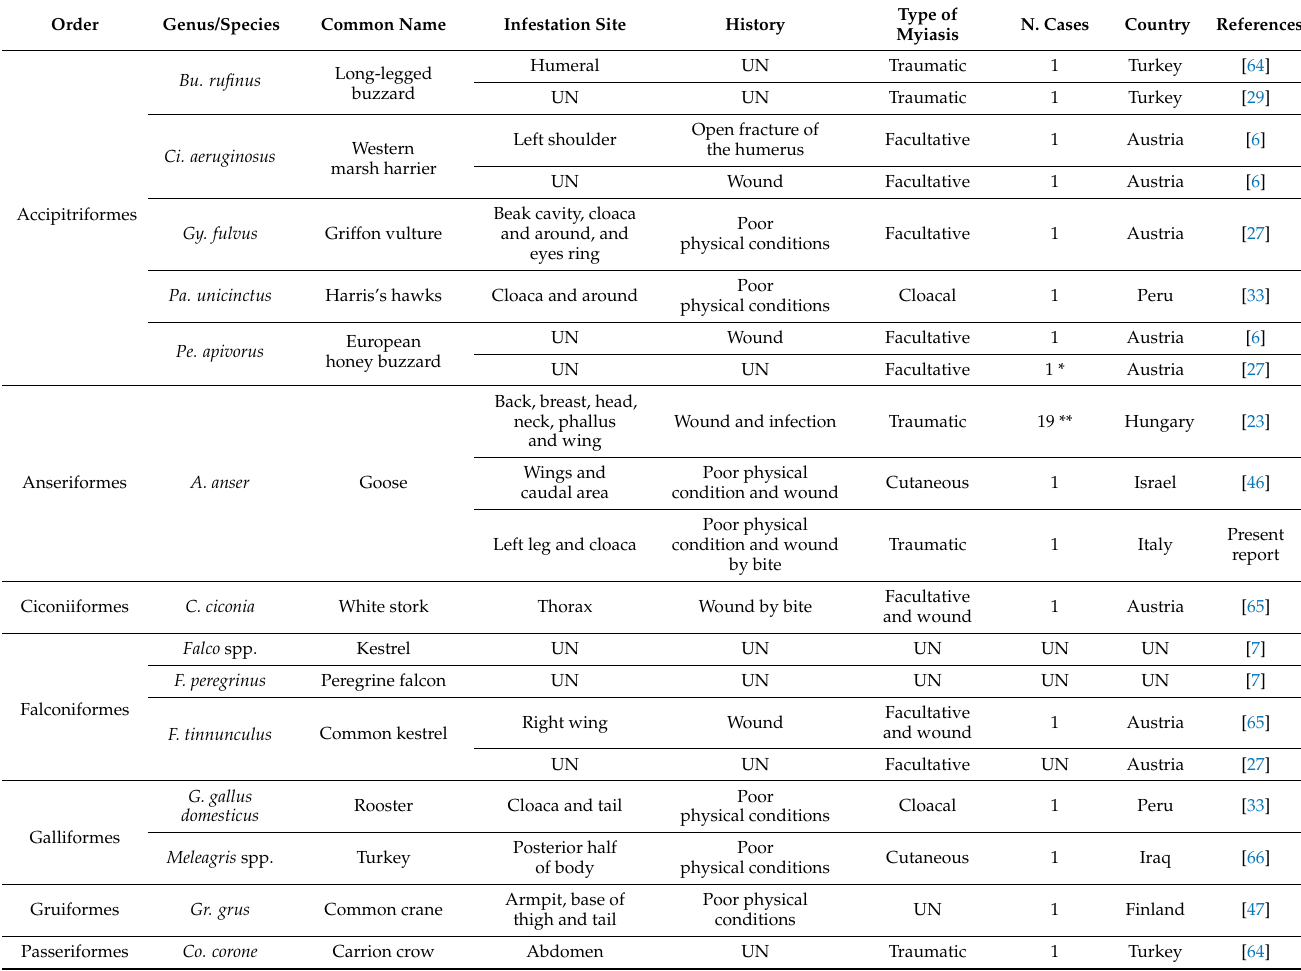
Table 1. Cases of myiasis by Lucilia sericata in birds. Abbreviations: A. anser , Anser anser ; As. flammeus , Asio flammeus ; As. otus , Asio otus ; B. bubo , Bubo bubo ; Bu. rufinus , Buteo rufinus ; C. ciconia , Ciconia ciconia